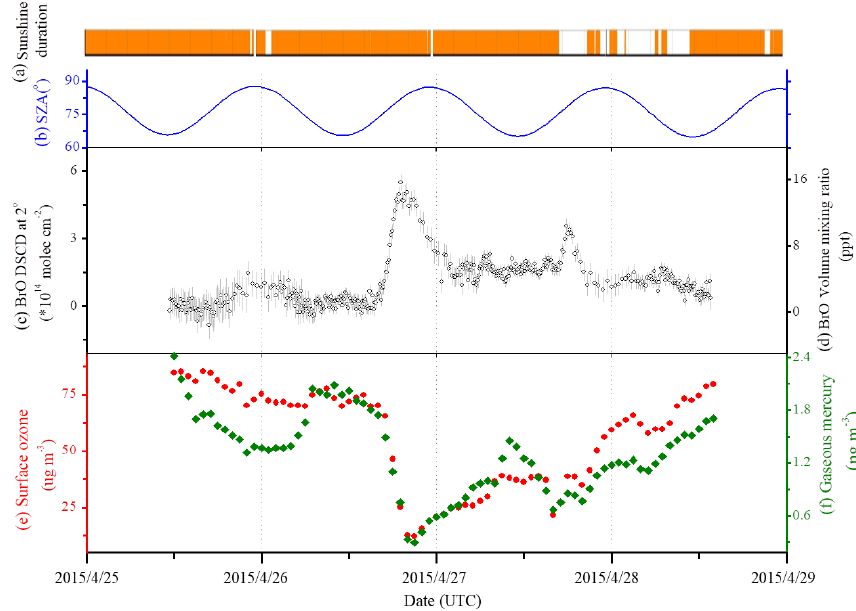
Figure 8. (a) Sunshine duration; (b) solar zenith angle; (c) BrO DSCDs from MAX-DOAS at elevation angle of 2 ◦ ; (d) BrO VMR (ppt); (e) surface ozone (ugm − 3 ) ; and (f) gaseous mercury (ngm − 3 ) from 25 April at noon to 28 April at noon 2015. BrO mixing ratios are calculated assuming a homogeneous BrO layer of